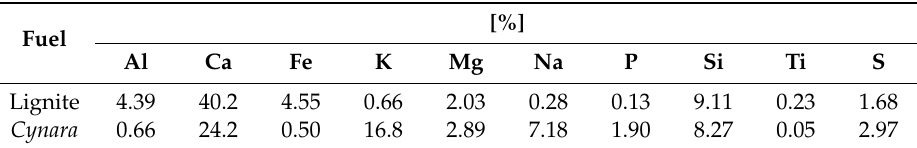
Table 3. Values for major and minor elements in the fuels.